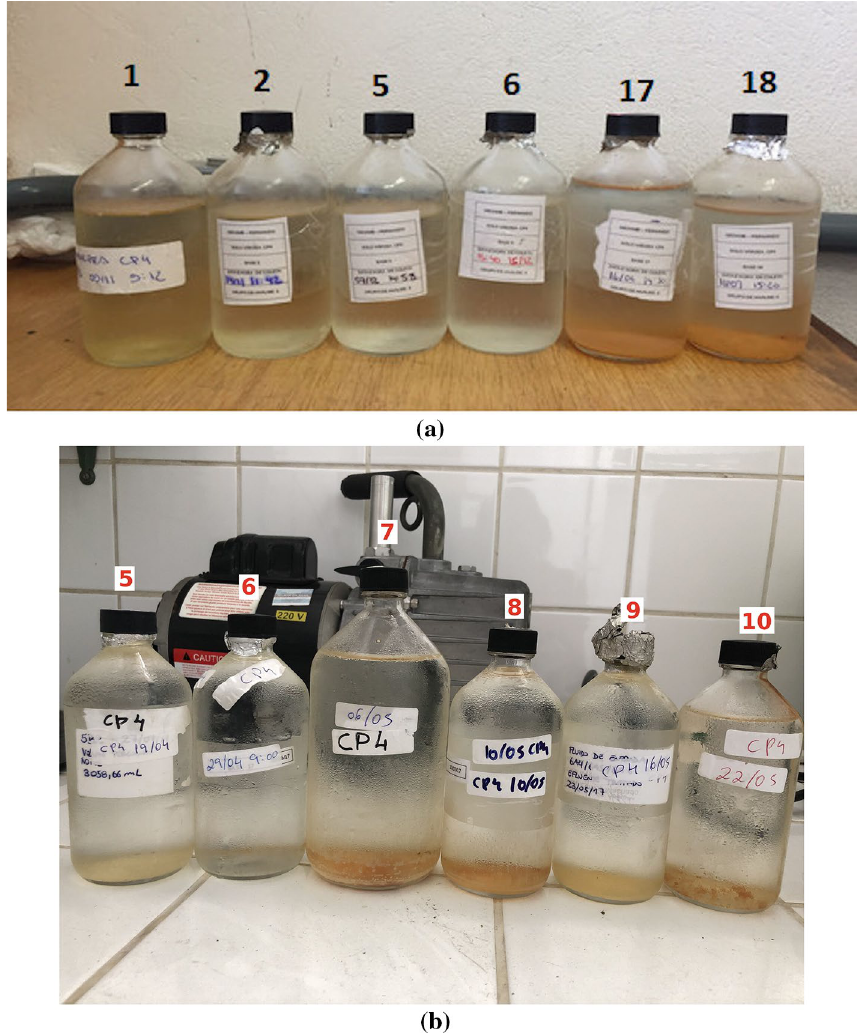
Figure 4. Photo of sampling jars containing percolated fluid. ( a ) First campaign and ( b ) second